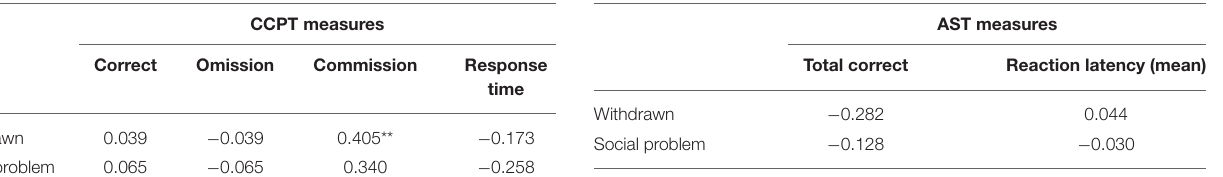
TABLE 4 | Correlation coefficients of the CCPT measures with the CBCL withdrawn and social problem subscale score in the control group.